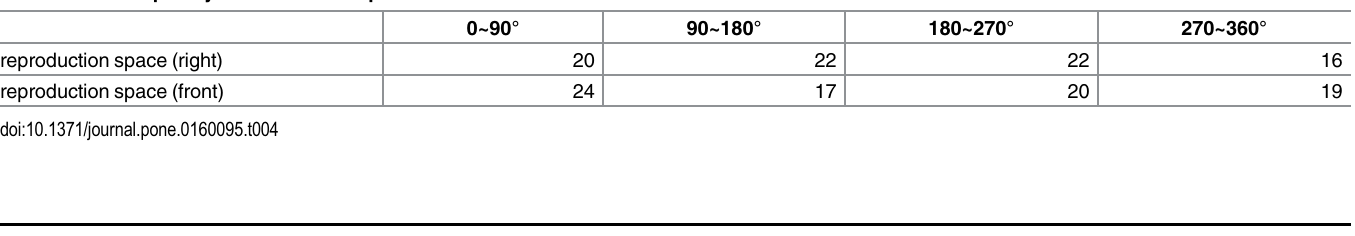
Table 4. The frequency of mean trials reproduced in the four